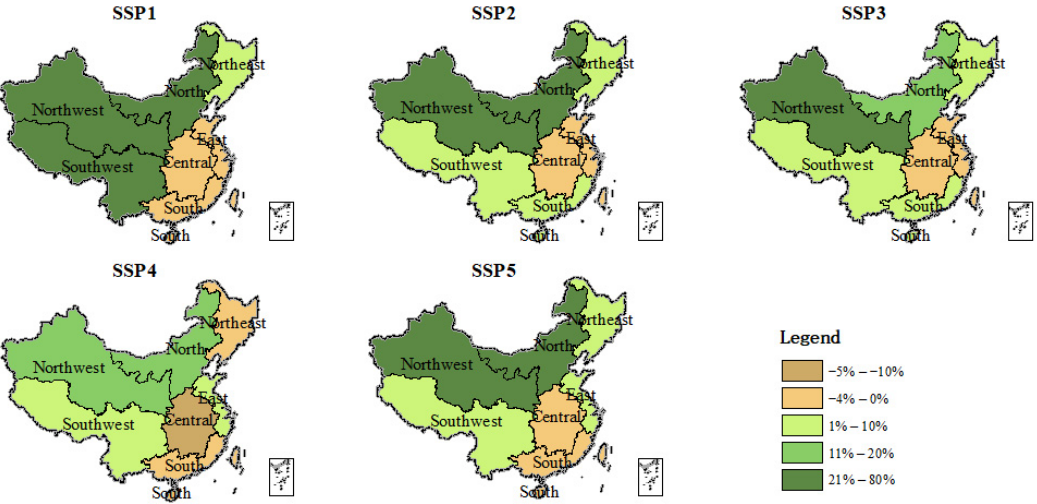
Figure 7. Commercial forest area changes across SSPs, from 2018 to 2068.